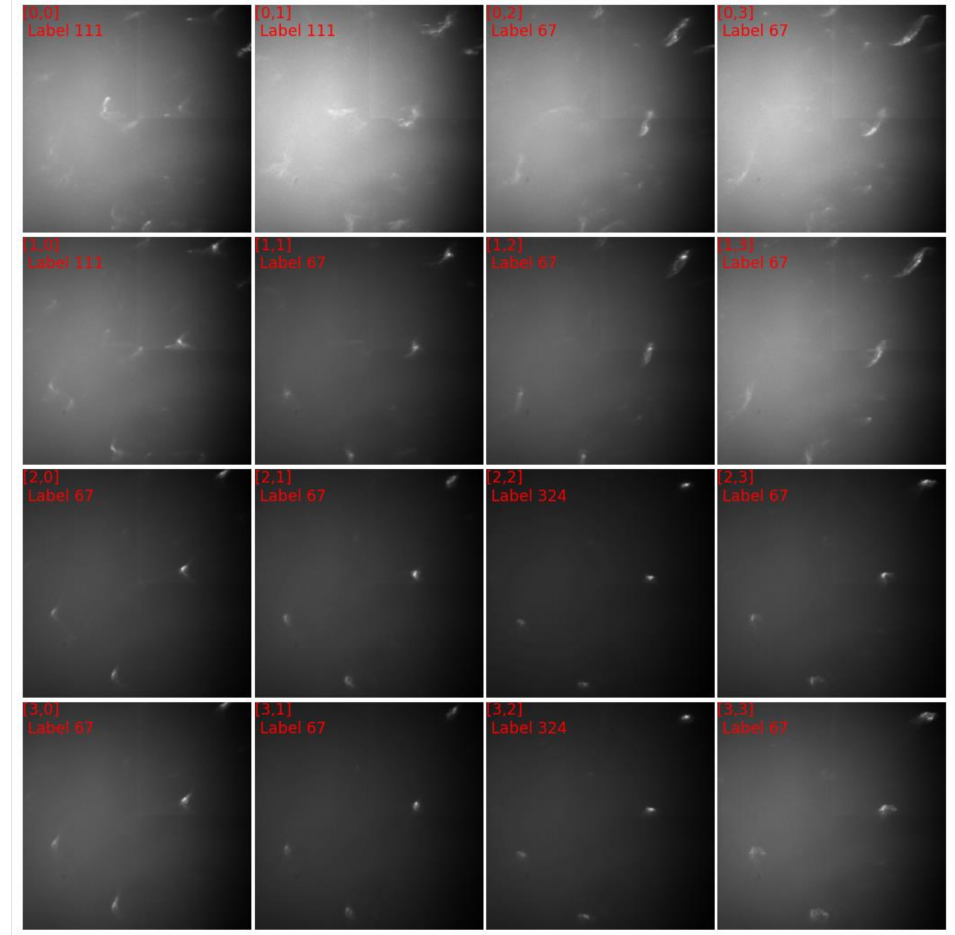
Figure 10. The diffraction images of subgrid B in Figure 7c.